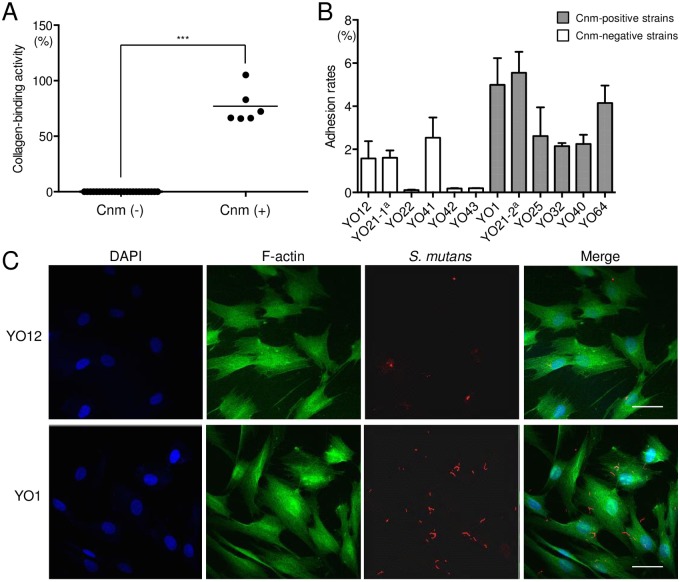
Virulence properties of S. mutans strains isolated from inflamed pulp specimens.(A) Binding to type I collagen of S. mutans strains. Significant differences were found (Student’s t test; ***P<0.001). (B) Adhesion properties of S. mutans strains with HDPFs. aYO21-1 and YO21-2 were isolated from the same patient. (C) Representative confocal scanning laser microscopic images of HDPFs isolated from a primary tooth. Nuclei are stained blue, F-actin is green, and bacterial cells adherent to HDPFs are red. Bars, 20 μm.